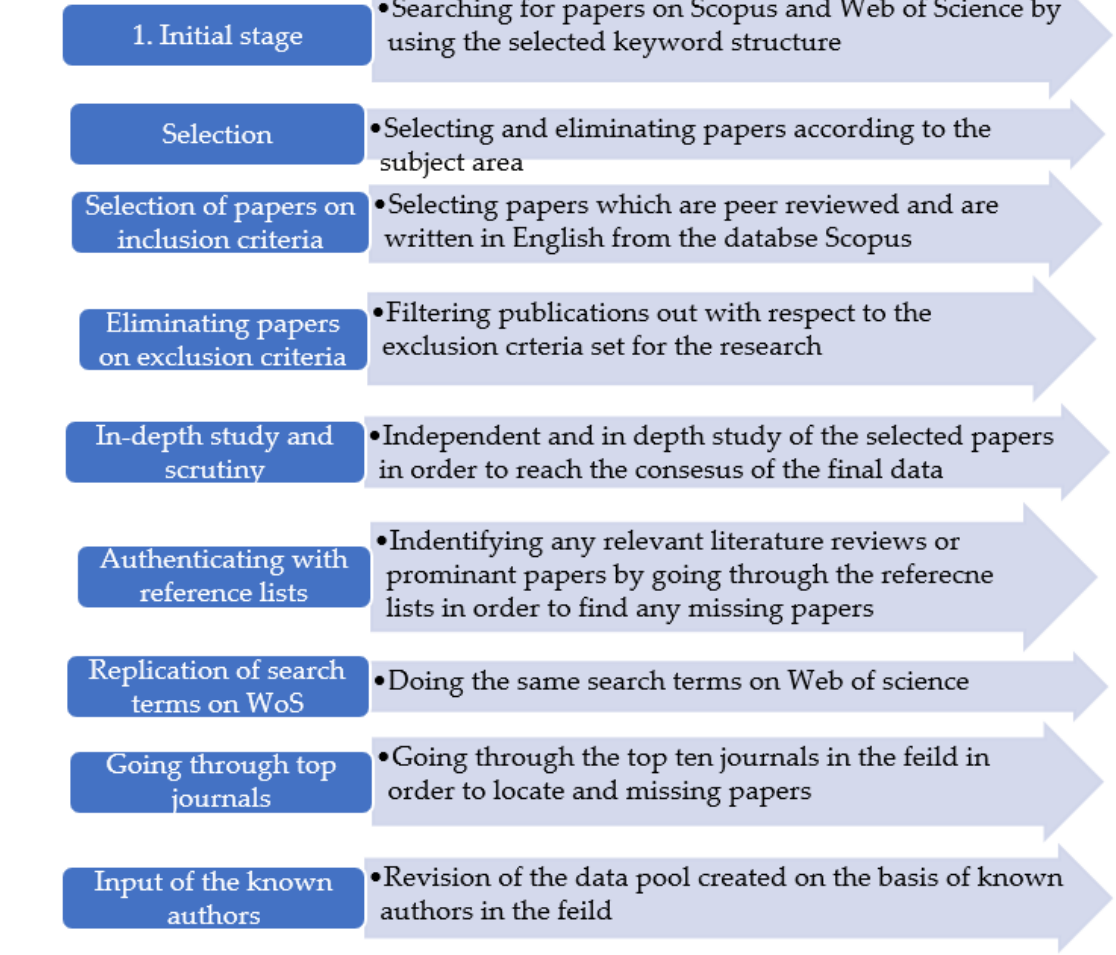
Figure 3. Process of gathering and refining the literature pool (adapted from [28]).